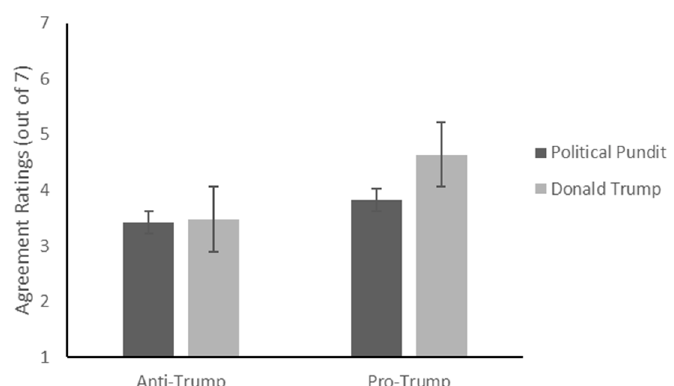
Figure 1. Agreement with the statement on a National Popular Vote by the participant with Trump support and a statement source.